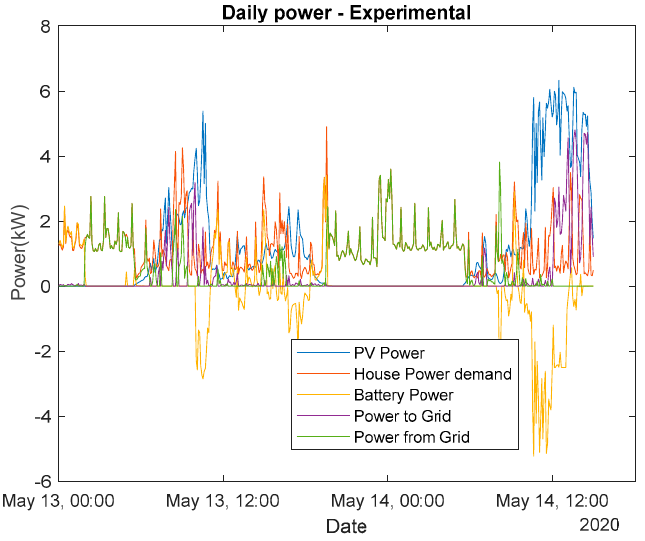
Figure 16. Different power signals—proprietary control (cloudy day).